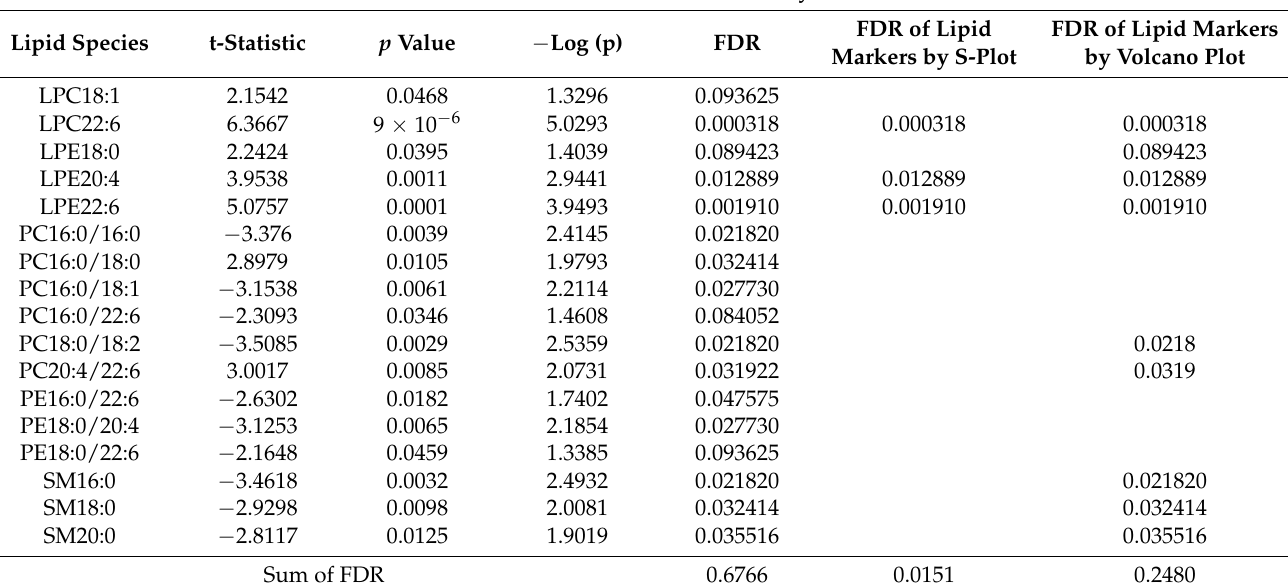
Table 1. List of lipid species showing statistical significance ( p < 0.05) between ischemic and normal brain parenchyma (N = 9 each, unpaired t -test), with their t-statistic, p value, − log(p), false discovery rate (FDR) of each listed lipid species, the sum of FDR from all listed lipid species, (the FDR column), from s-plot of OPLS-DA-identified markers, and from volcano-plot-identified markers. Normal vs. Ischemic Brain Parenchyma